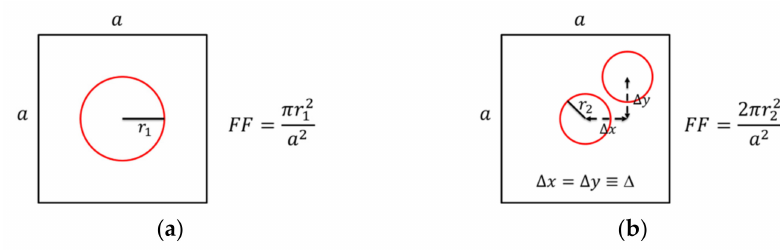
Figure 2. The unit cells of ( a ) single-hole and ( b ) double-hole PC